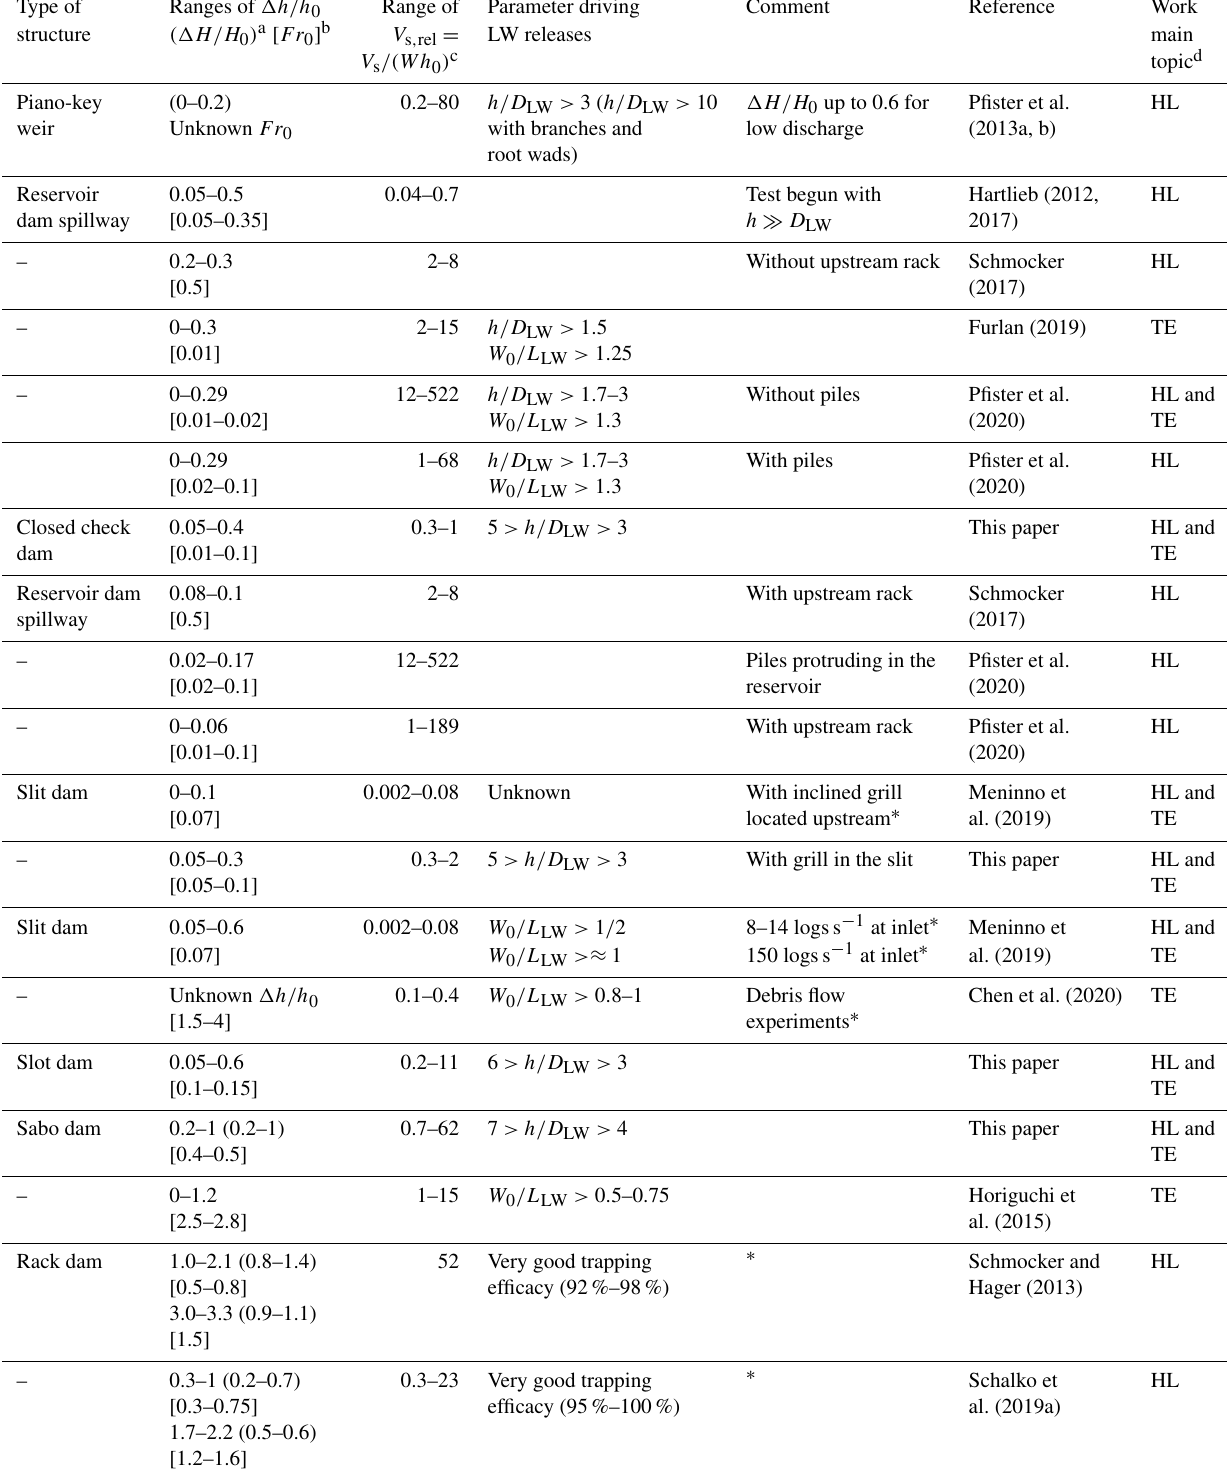
Table 2. Literature review of existing results on LW-related head losses and release